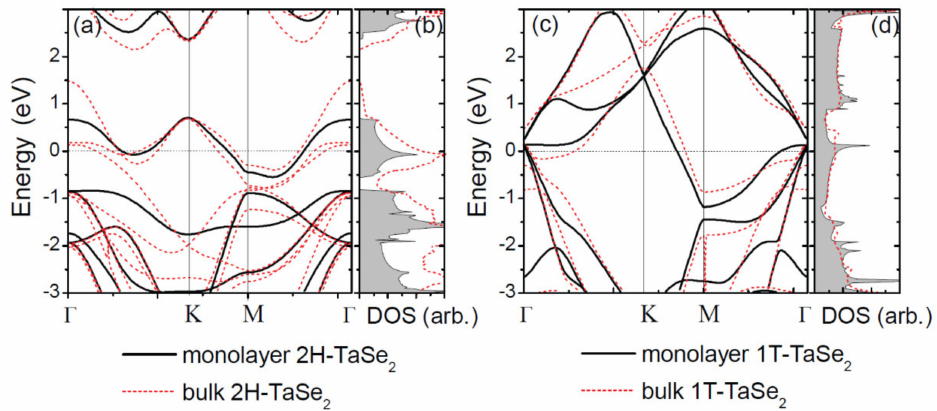
Figure 11. ( a ) Electronic-band structure and ( b ) the DOS for monolayer 2 H -TaSe 2 . ( c , d ) Results for monolayer 1 T -TaSe 2 . Band structures and the DOS of bulk are shown as red dashed lines. The Fermi level was shifted to zero. Reference [82] is an open-access article distributed under the terms of the Creative Commons CC BY (https://creativecommons.org/licenses/ (accessed on 14 December 2021).) license, which permits unrestricted use, distribution, and reproduction in any